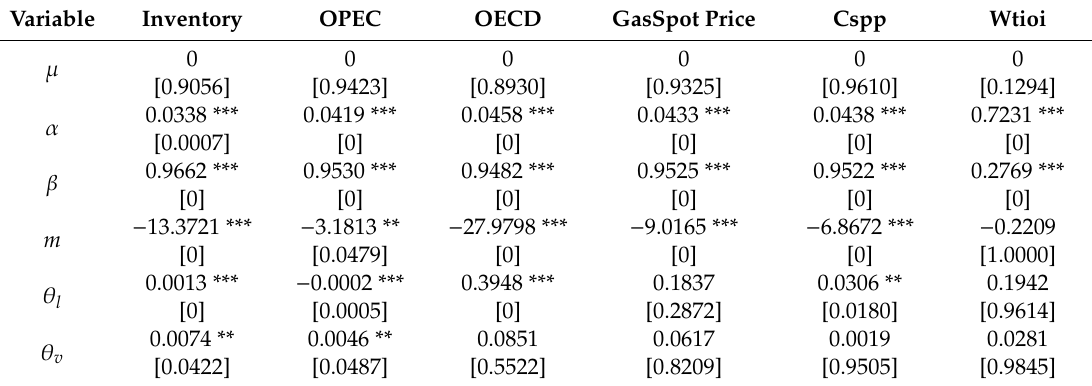
Table 7. Estimation results of associative model of level and fluctuation e ff ect in low-frequency